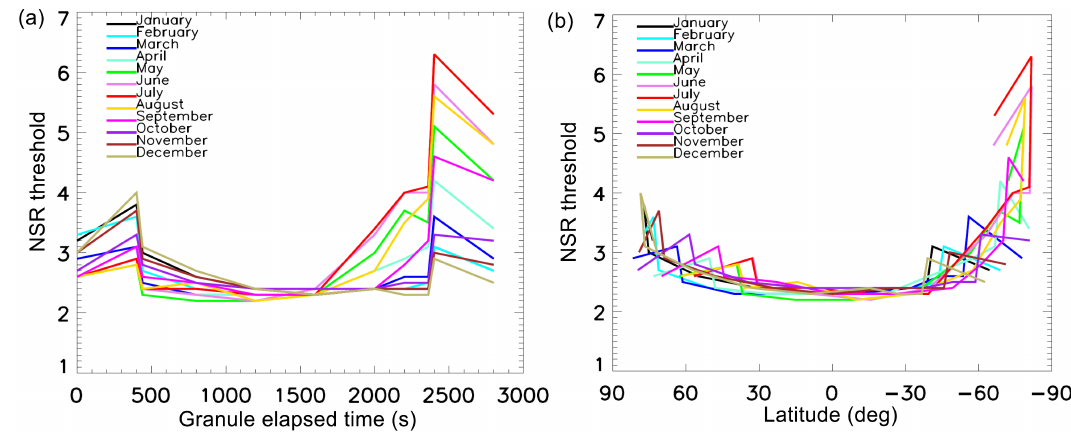
Figure 5. The NSR thresholds employed in V4 algorithm for various months (same for all years) as a function of granule elapsed time (a) and latitude (b) . The granule elapsed time starts in the Northern Hemisphere at the day-to-night